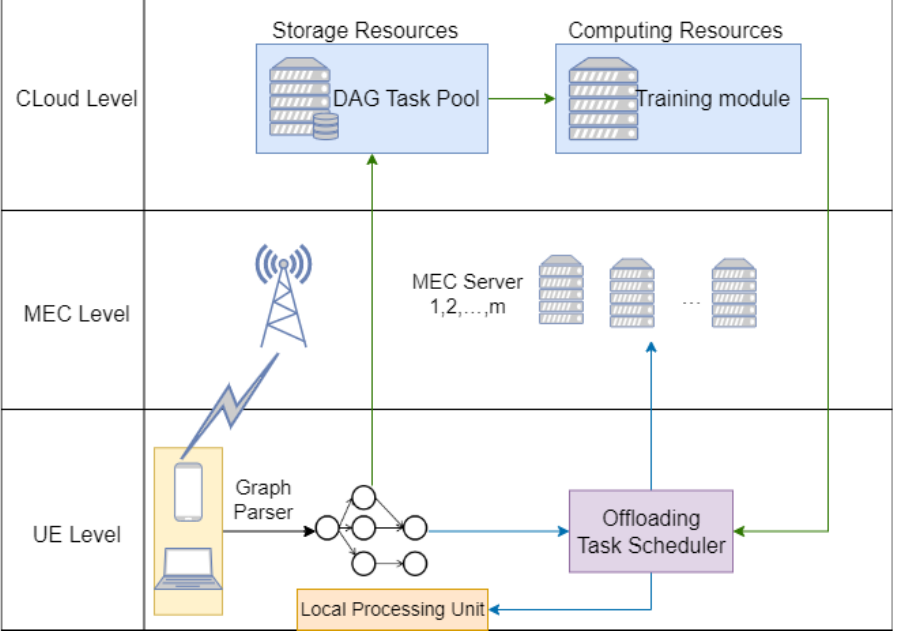
Figure 1. DRL-based MEC Offloading Scheme.